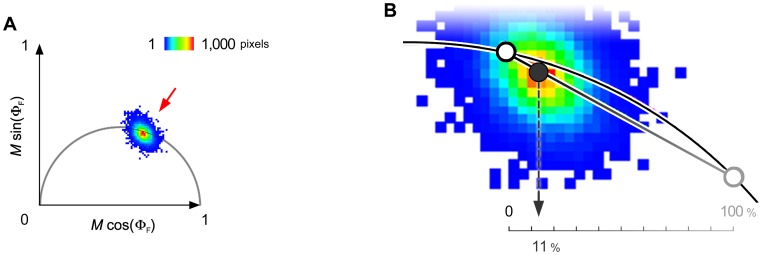
Percentage of interaction.A. All pixels from an image are plotted on a single Polarplot. Averages of fluorescence lifetime in individual pixels cluster around a ‘mean’ lifetime (red arrow). B. The known baseline lifetime, i.e., 2.56 ns, defines 0% FRET percentage on the semicircle (black open circle). A straight line projecting through the ‘mean’ lifetime (black circle) intersects with the semicircle at 100% FRET percentage (grey open circle). The position of the ‘mean’ in respect to the 0% and100% FRET is the estimate of percentage of interaction between the pair of proteins examined.